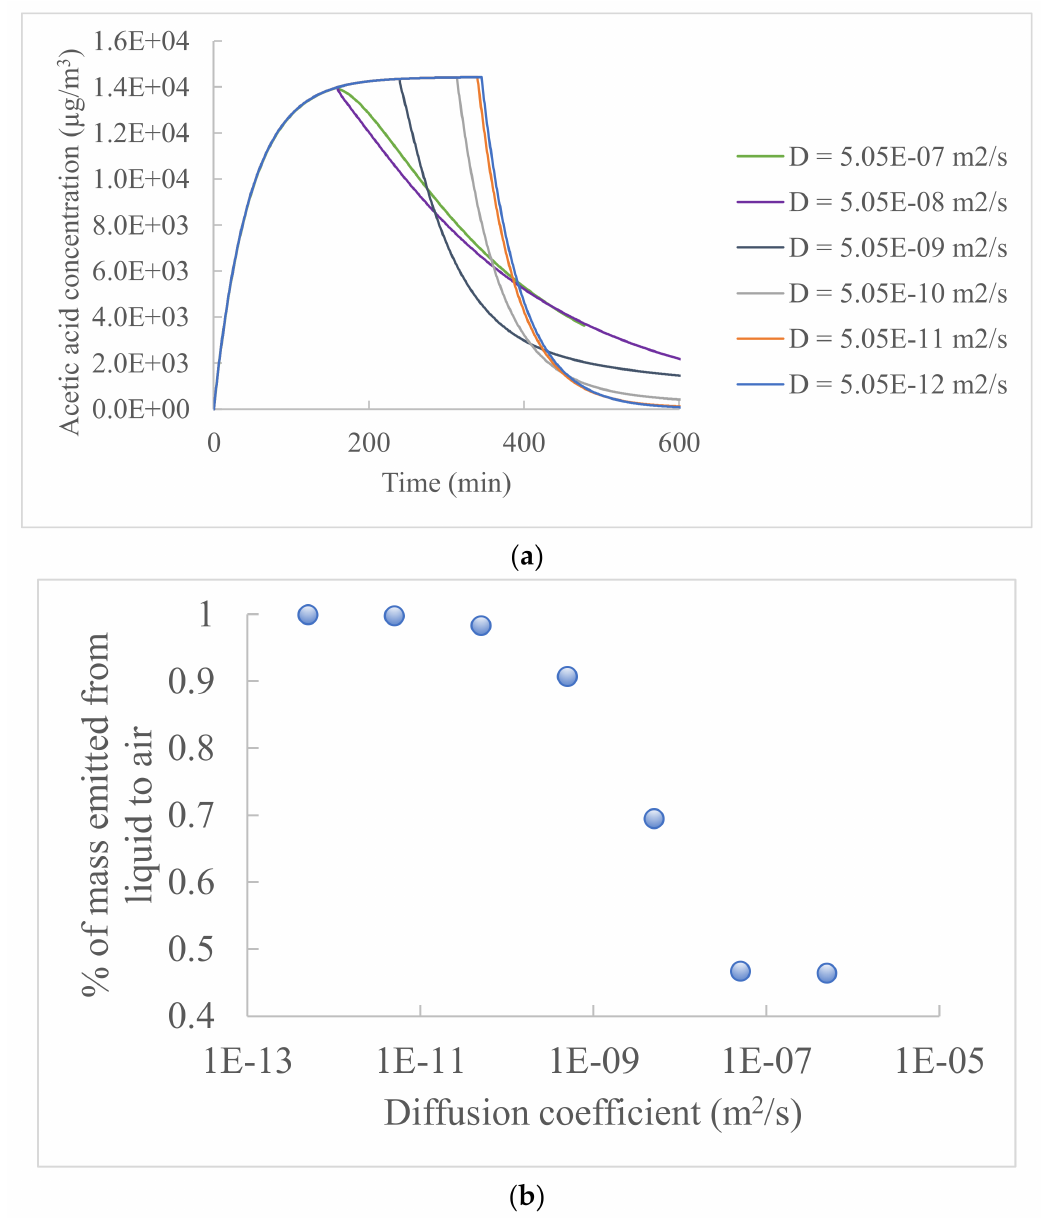
Figure 3. Influence of diffusion coefficient ( D ) on the indoor gas-phase concentration of acetic acid: ( a ) concentration profile and ( b ) fraction of mass emitted from the product liquid to